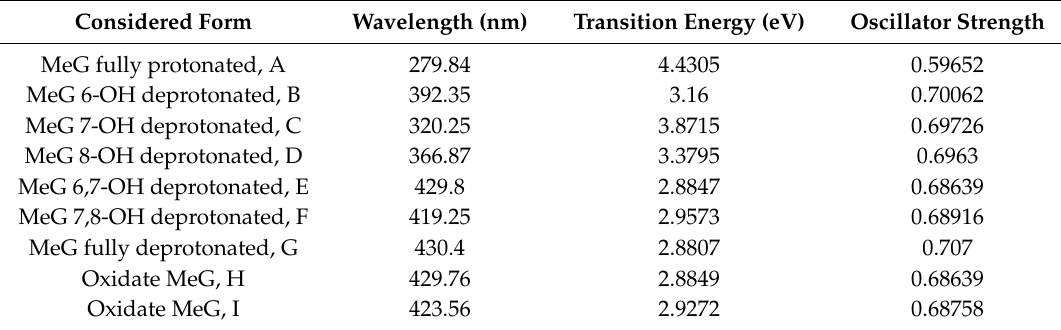
Figure 3. Proposed deprotonated and quinoid methyl gallate structures used to calculate spectra by Gaussian. Table 1. Lowest energy transition wavelength and oscillator strength calculated for the different protonation states of methyl gallate and quinoid methyl gallate.